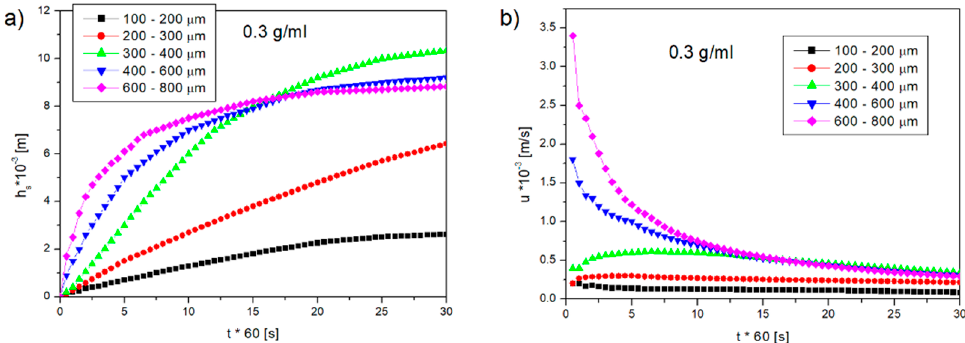
Figure 4. Dependence plot of ( a ) sediment layer height and ( b ) sedimentation velocity during the process for the sedimentation of microspheres with a concentration of 0.3 g/mL in an emulsion with a concentration of 70%, d e1 .